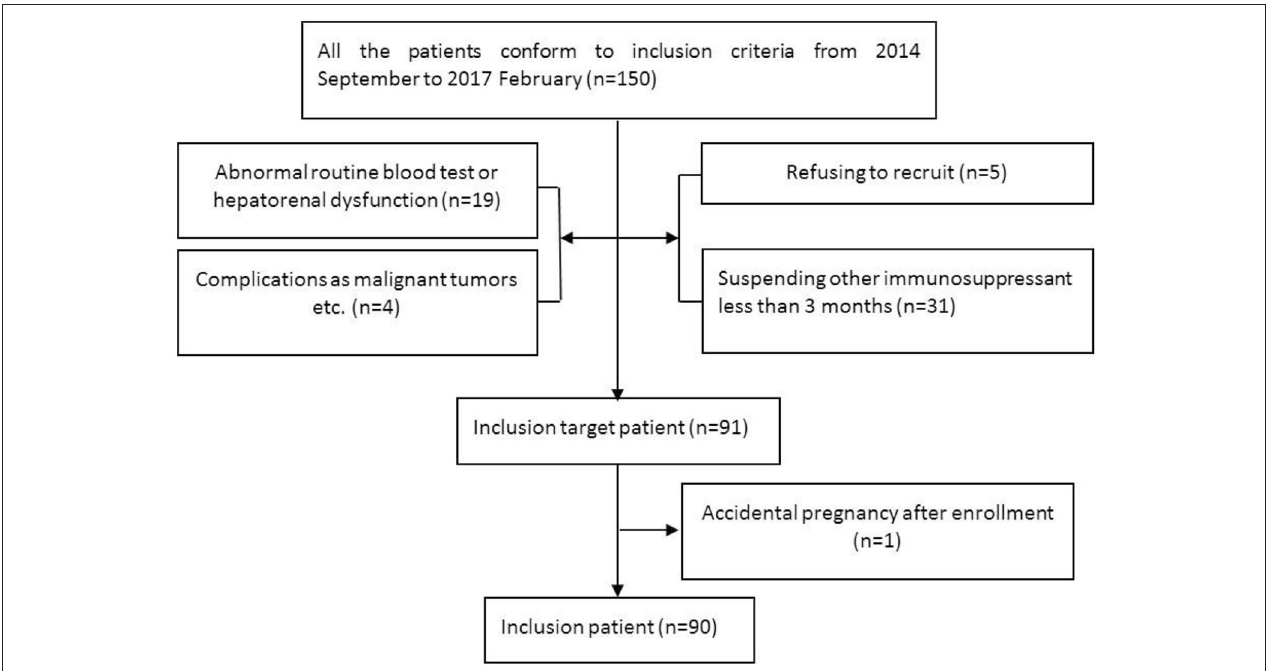
FIGURE 1 | Flow chart of the inclusion and exclusion